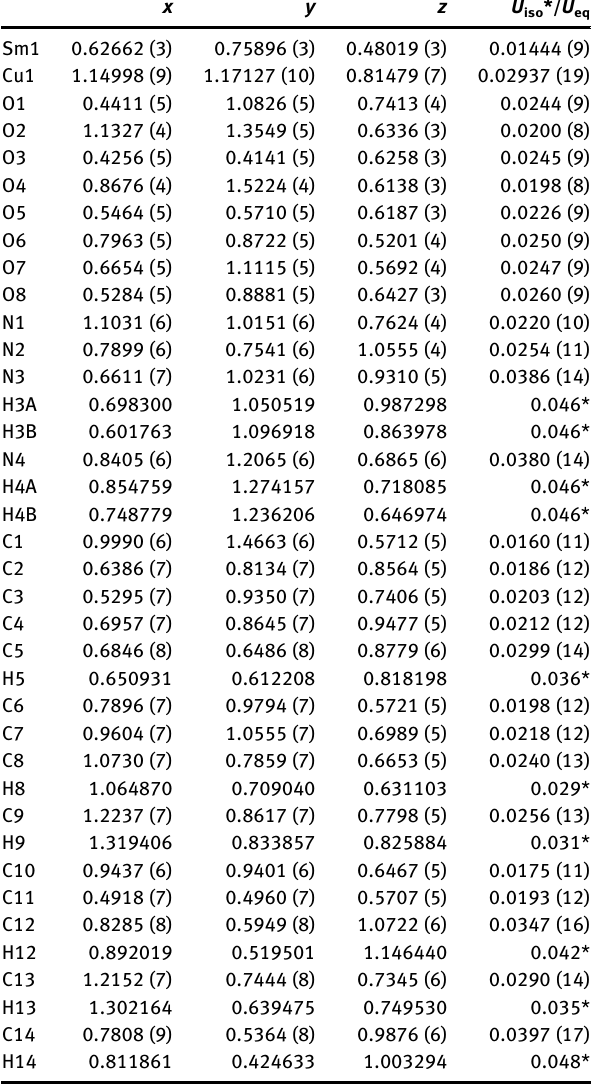
Table  : Fractional atomic coordinates and isotropic or equivalent isotropic displacement parameters (Å 